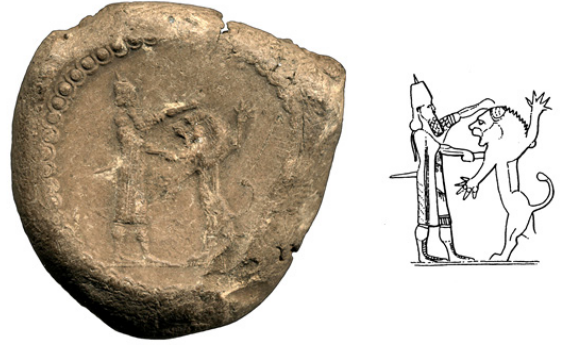
Figure 14. King slaying lion (BM inv. no. 84672; reg. no. 1851,0902.191); clay seal impression; Nineveh (mod. Iraq); Assyrian, ca. 9th–8th cent. BCE ; with line drawing [image courtesy of the Trustees of the British Museum, London].